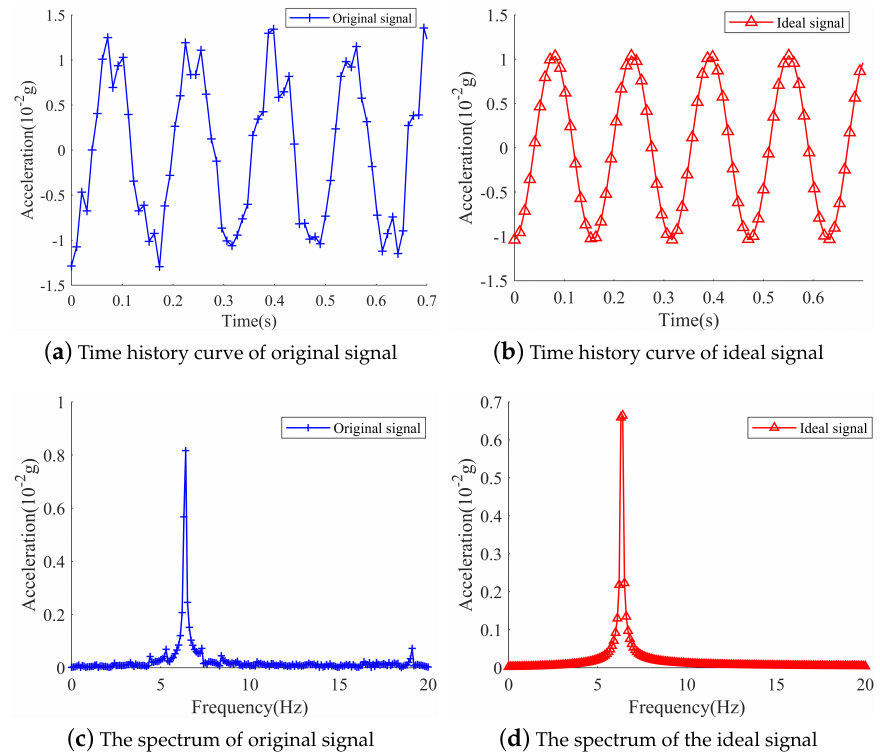
Figure 14. Effect comparison before and after